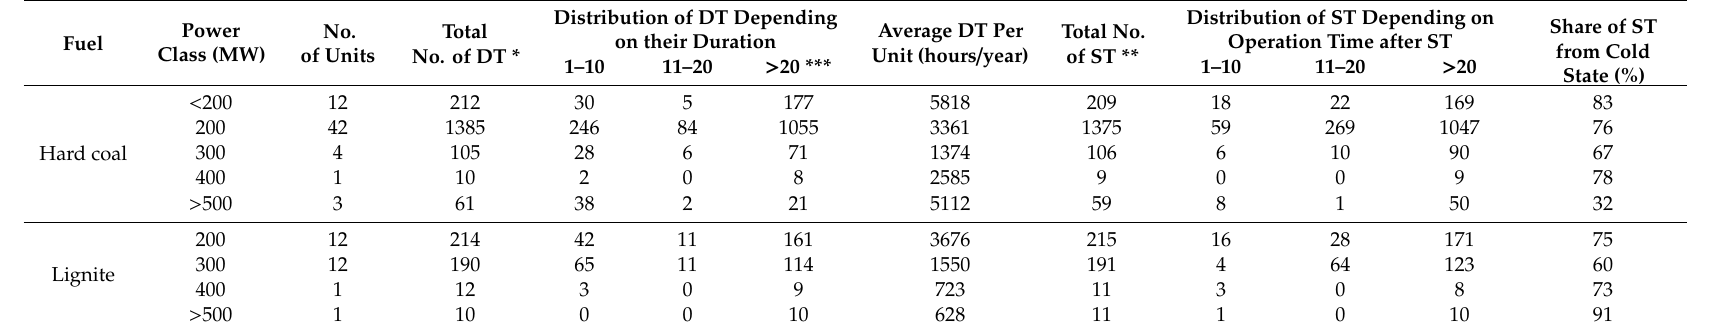
Table 1. Selected statistics summarizing the operation of centrally dispatchable generation units (JWCD) coal units in